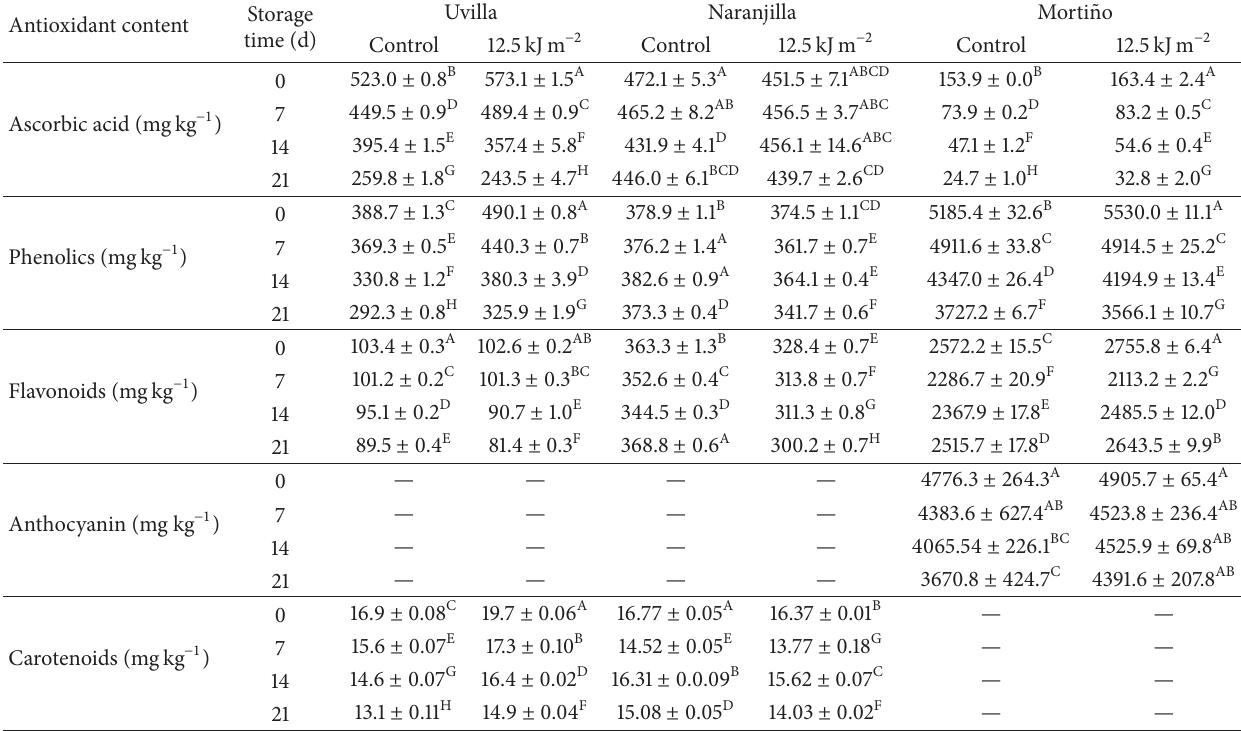
Table 2: Ascorbic acid, total phenolics, flavonoids, anthocyanins, and carotenoids in control and UV-C treated (12.5kJm −2 ) uvilla, naranjilla, and morti˜no stored at 6 ∘ C for 0, 7, 14, or 21d. For each fruit, different letters between treatments show differences according to a Fisher test ( 𝑃 < 0.05 ). The mean ± standard error is